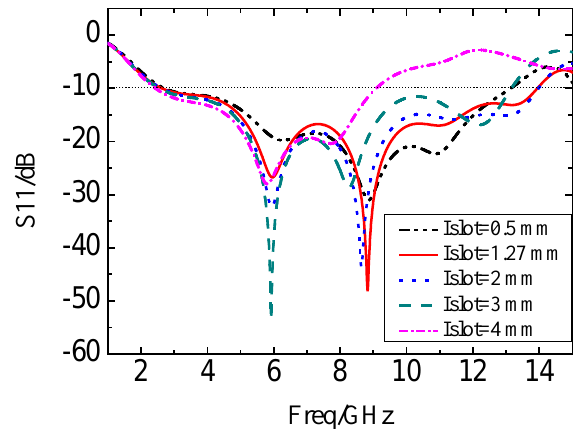
Figure 11. Simulation results of the reflection coefficient of antennas with the varying I-shaped slot length.